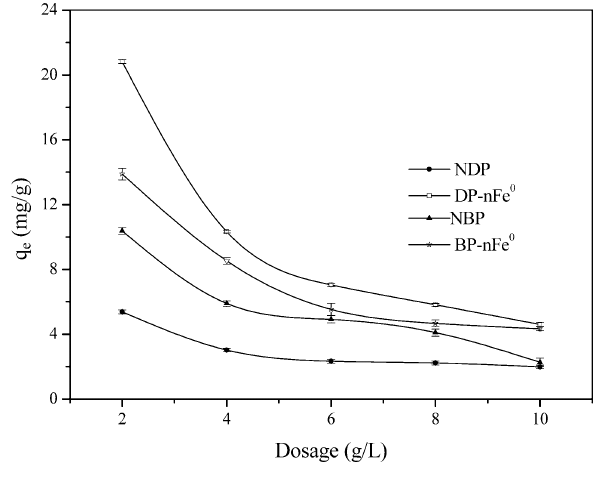
Fig. 4 Effect of NDP, NBP, DP-nFe 0 and BP-nFe 0 mass on chromium removal (Cr(VI) concentration = 50 mg/L, contact time 60 min, pH 2, 25 °C temperature and 250 rpm agitation speed)